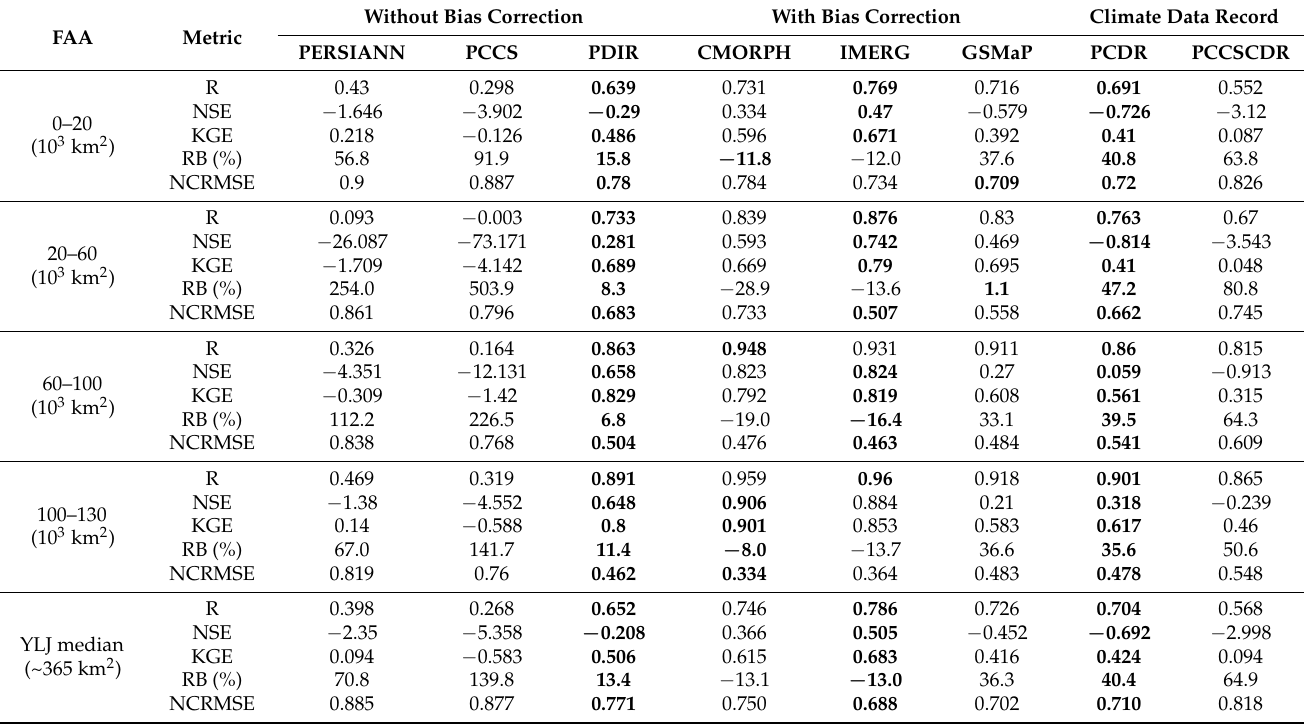
Table 4. The discharge simulation performance (median) of eight products in different catchment area intervals. Pearson correlation coefficient (R); Nash–Sutcliffe efficiency (NSE); Kling–Gupta efficiency (KGE); Relative bias (RB); Normalized centered root mean square error (NCRMSE). The values shown in the table are the median of each